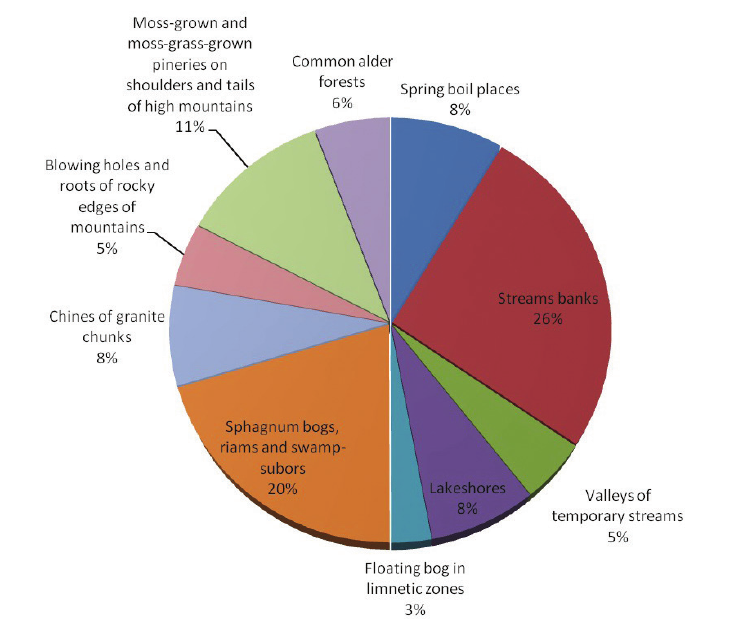
Figure 6. Percentage of rare species confined to a particular ecotope of the study area.